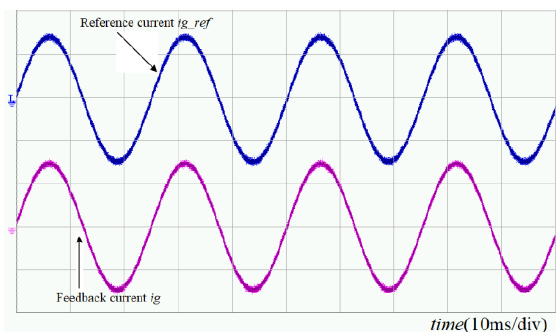
Figure 17. Reference current ig_ref and feedback current ig of the motor.